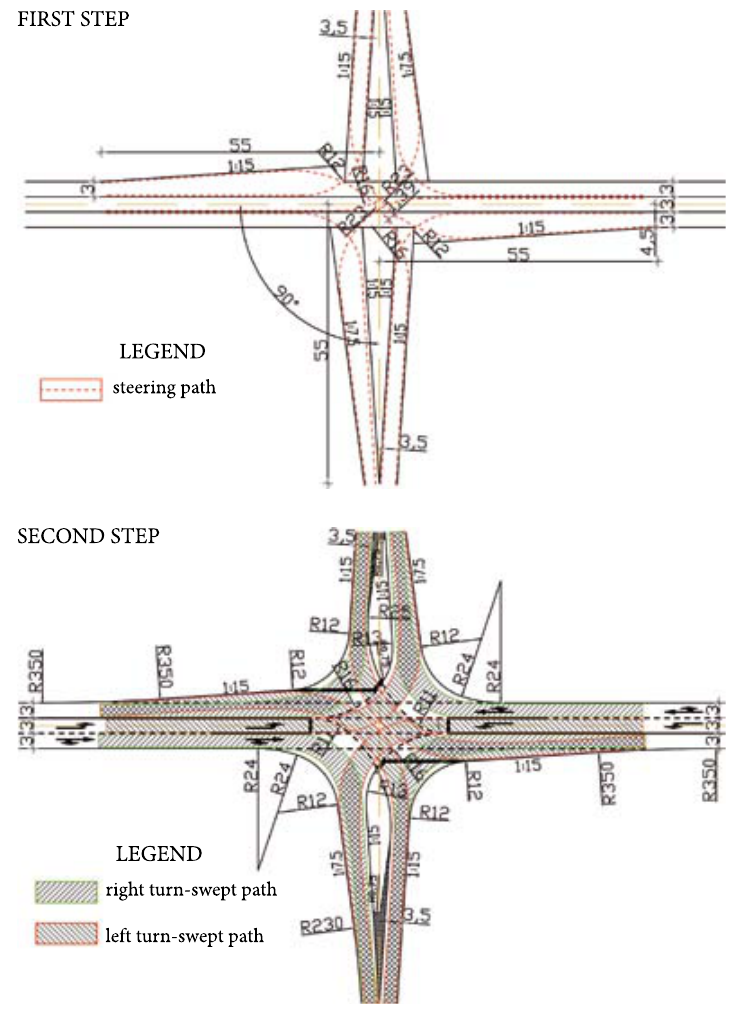
fig. 9. Four-leg intersection at grade (90°-angle between main and auxiliary traffic